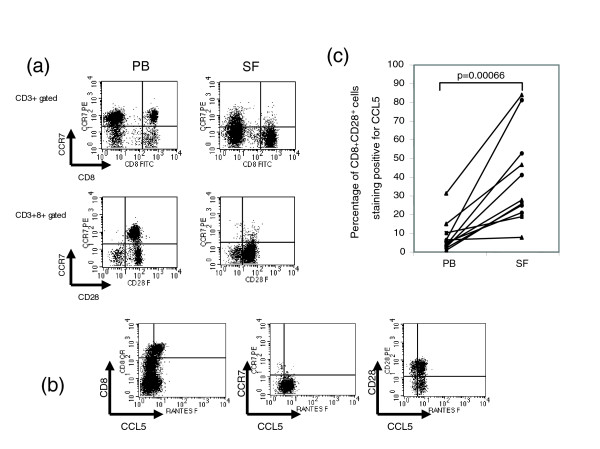
The phenotype of CCL5+ synovial T cells diverges from the effector memory phenotype. Flow cytometric analysis of peripheral blood (PB) and synovial cells. (a) Cells were stained for CD3, CD8 and CR7 and CD28. The majority of synovial fluid (SF) T cells were CCR7- (upper panels). However, within the CCR7- population of CD8+T cells, synovial T cells showed maintained high expression of CD28 compared to CD8+CCR7- T cells from PB (lower panel). (b) Costaining for CD8, CCR7, CCL5 and CD28 confirmed that the synovial CCR7-CD28+CD8+ cells also contained high levels of intracellular CCL5; positive staining for CCL5 was defined by comparison with isotype-matched control staining. (c) The pattern of CCL5+ staining seen in CD8+CD28+ T cells was seen in a total of 11 sets of samples (4 persistent oligoarticular, closed triangles; 5 extended oligoarticular, closed circles; and 2 polyarticular, closed squares), when comparing cells from PB and SF.